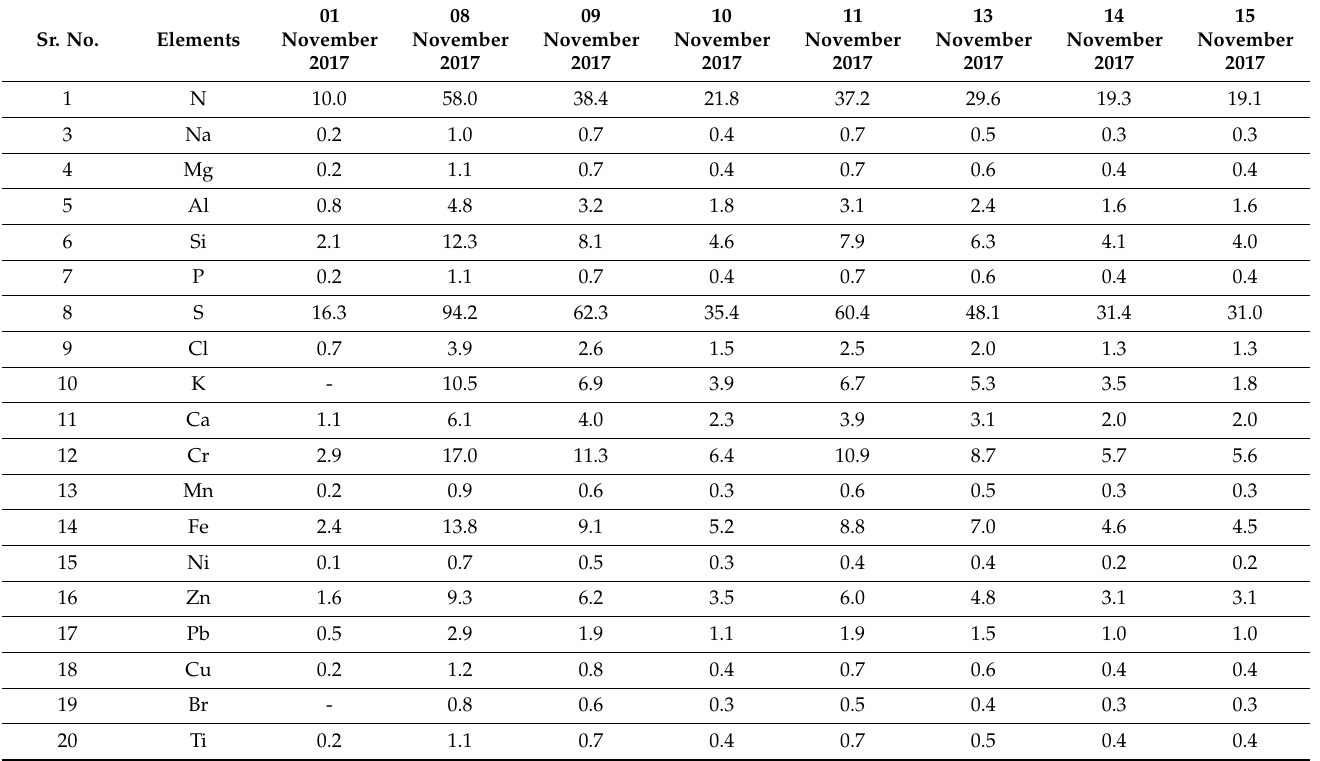
Table 3. Variations in PM 2.5 associated elements ( µ g/m 3 ) during